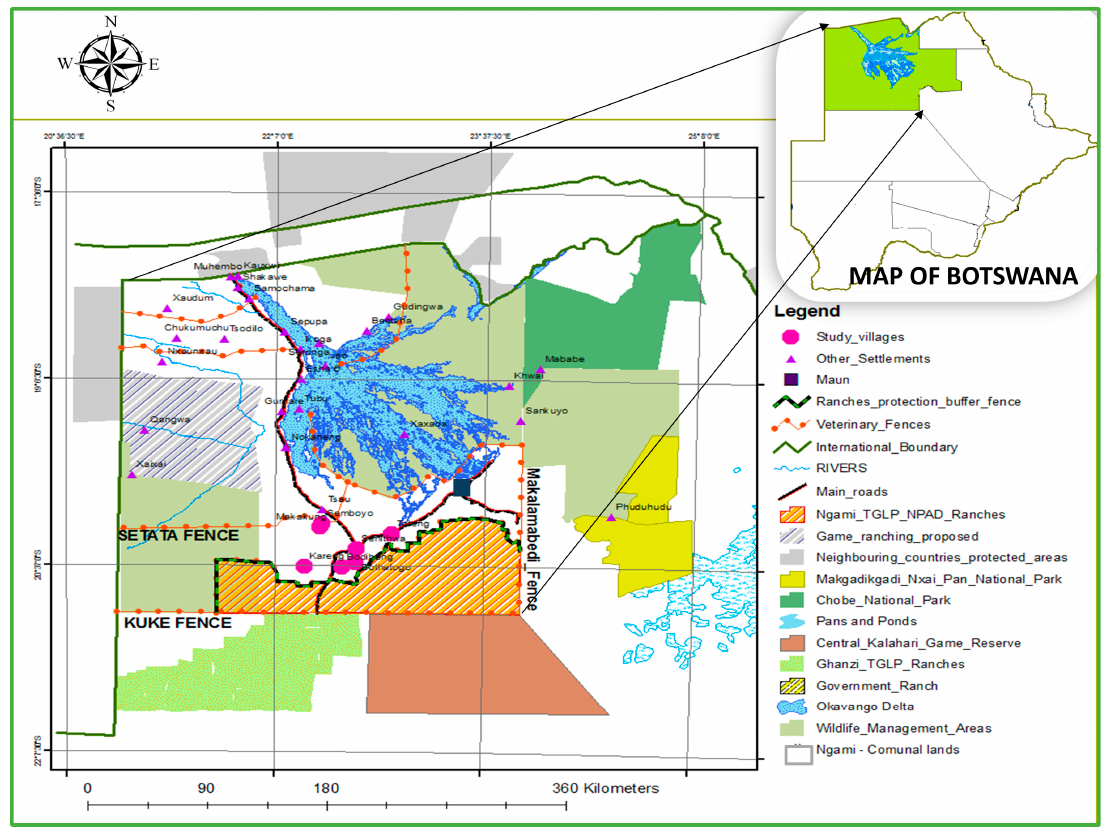
Figure 2. Map showing land use and tenure transformation in Ngamiland, Botswana; increased landscape fragmentation due to rangeland enclosures, privatisation and veterinary fences.